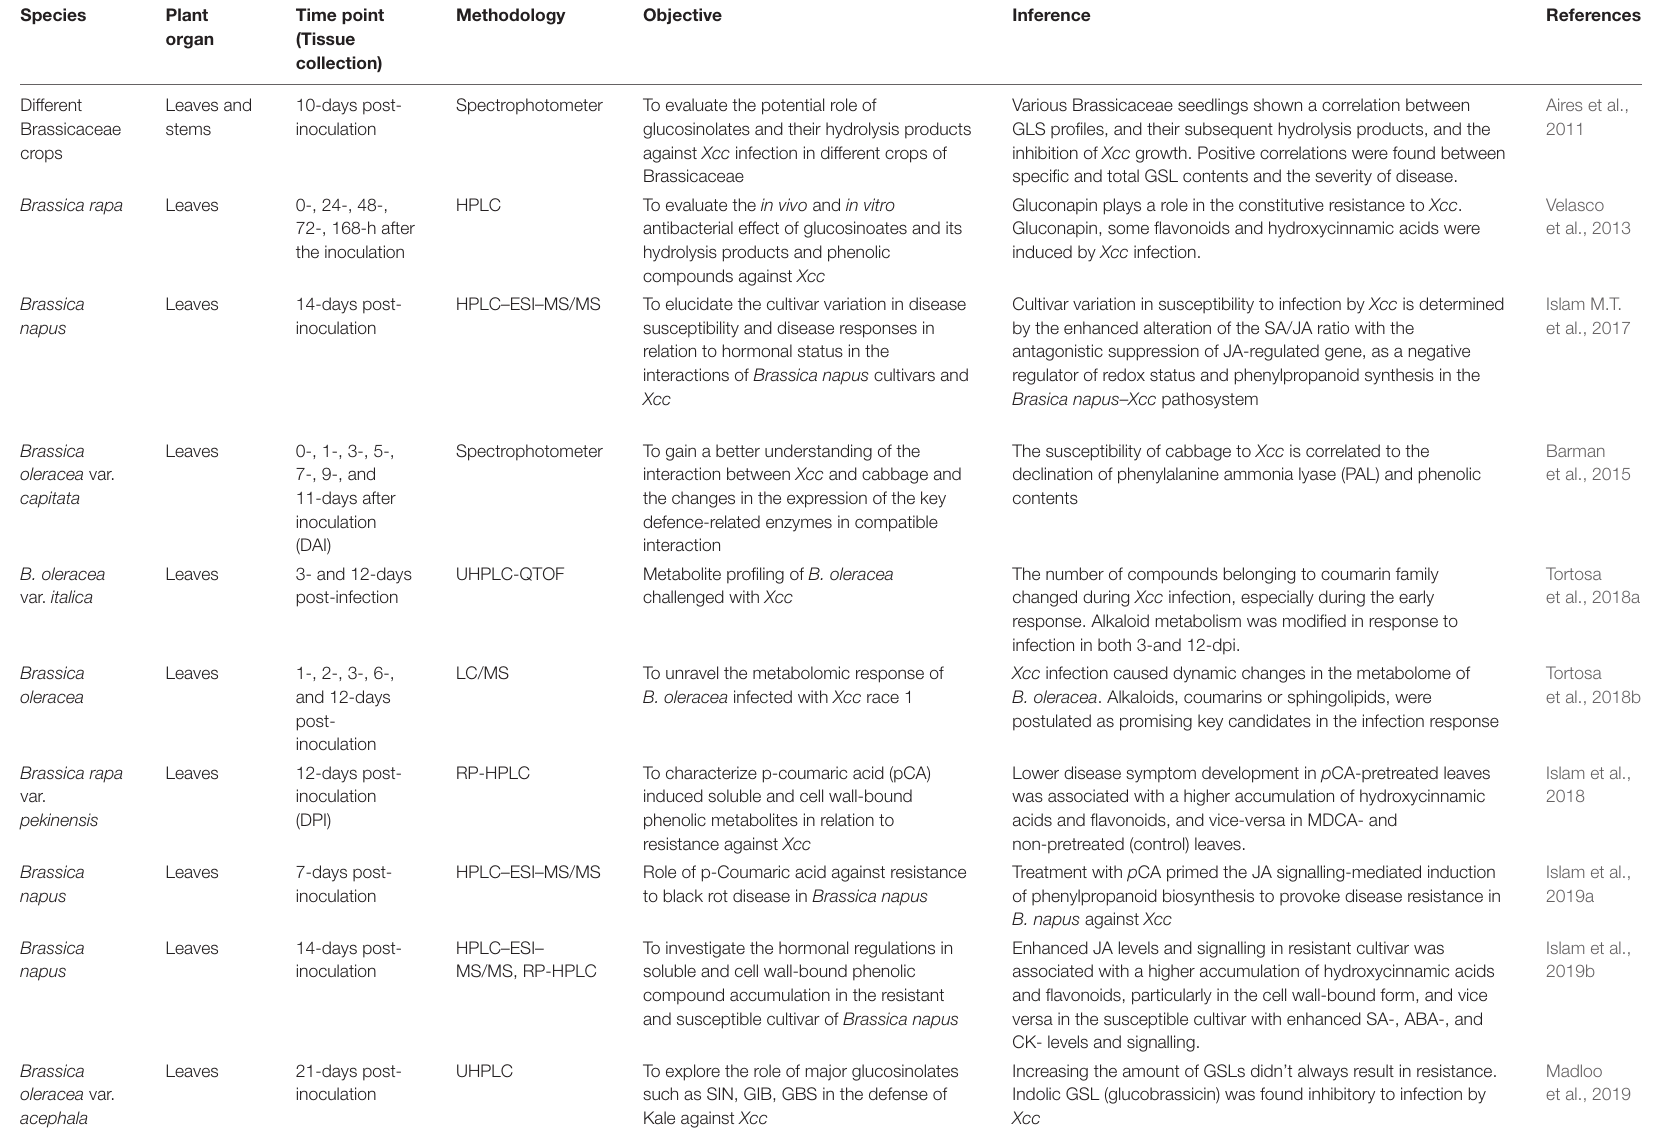
TABLE 5 | Published metabolomic analyses in Brassica species involved in resistance against black